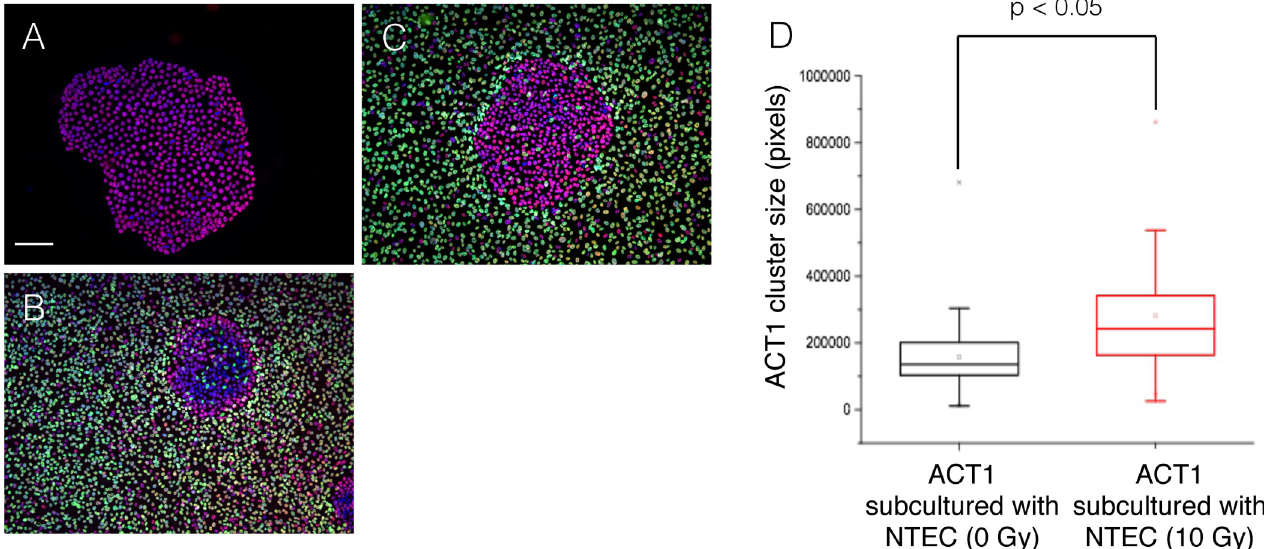
Fig 10. Reduced cell competition between terminally arrested NTECs and ACT1 cell cluster. ACT1 cells were cultured for 5 days until they formed small cell clusters and then GFP-NTECs irradiated with 10 Gy of γ -rays were added and cultured for 3 more days. ACT1 cluster sizes were measured 3 days later (on Day 8). ACT1 clusters and GFP-NTECs were fixed and stained with anti-53BP1 antibody (red fluorescence). (A) ACT1 cluster in monoculture. (B) ACT1 cluster co-cultured with GFP-NTECs at Day 8. (C) ACT1 cluster with 10 Gy-irradiated GFP-NTECs at Day 8. (D) Comparison of the ACT1 cluster sizes. Statistical difference was evaluated by Mann-Whitney test. The bar indicates 100 μ